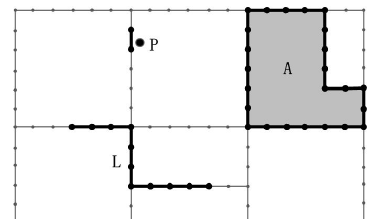
Figure 1. Illustration of a network quadrat system. Each segment is divided into quadrats of a defined network length, and the end points of quadrats are presented as dots. Here, Point generator P , Line generator L and Area generator A is projected on the corresponding generator quadrats , depicted as dark quadrats.